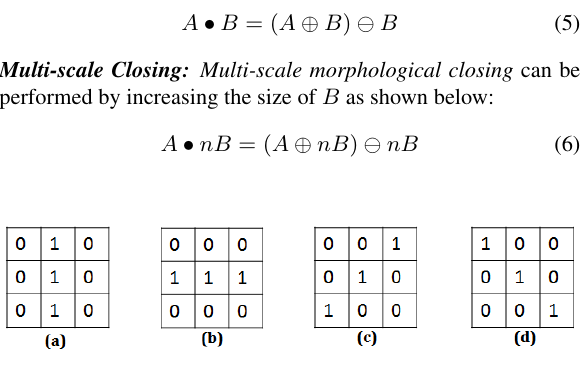
Figure 1. Four directional structuring elements: (a)